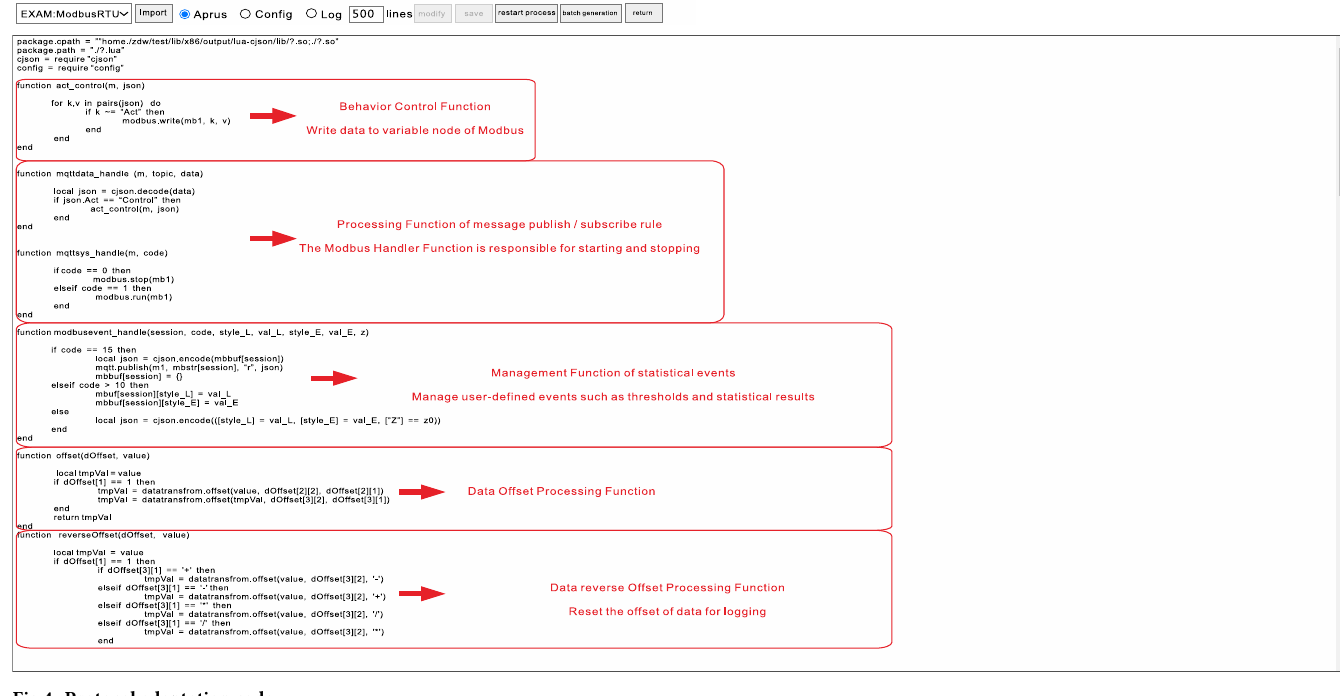
Fig 4. Protocol adaptation